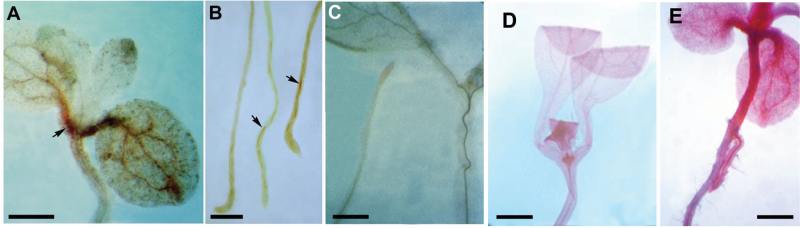
Ectopic expression of lignin and pectin in hlq seedlings. Phloroglucinol staining for lignin in hlq shoot (A) and roots (B) shows ectopic deposition of patches of lignin (arrows). Wild-type (C) staining for lignin showed a faint signal only in the vasculature. Bars=1mm for (A, C); 2mm for (B). (D, E) Ruthenium Red staining for pectin. Ten-day-old wild-type seedlings (D) showed faint staining in the vasculature, meristem, and leaf primordium, whereas there was ectopic deposition of pectin in hlq (E) throughout the vasculature, leaves, and hypocotyl. Bar=1mm.